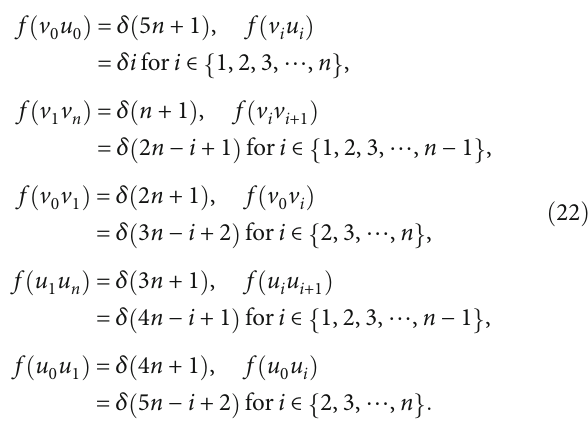
Figure 5: The double wheel graph W